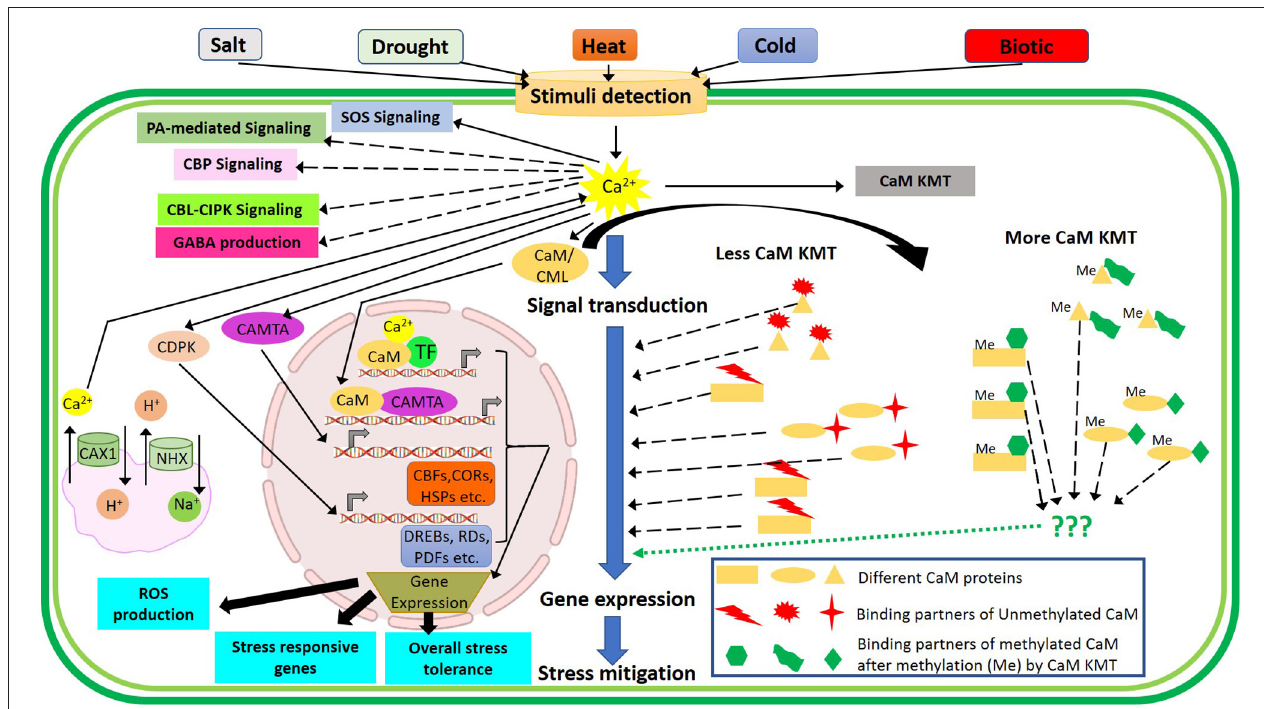
FIGURE 5 | Illustrative representation of crosstalk among Ca 2 + signaling components associated with multiple stimuli perceived by the plants. Spike in [Ca 2 + ] cyt triggers several pathways like SOS signaling, PA-mediated signaling, CBP signaling, CBL-CIPK signaling, GABA production, CAX1, and NHX regulation and activates CDPK, CAMTA, CaM, and CML for subsequent expression of stress-responsive genes in the nucleus depending on the types and magnitudes of stimuli. Calmodulin-lysine N-methyltransferase (CaM KMT) methylates CaM proteins in the cytosol while the methylated CaM (Me) and unmethylated CaM depicts differential interactions with CaM-binding partners (depicted in green and red shapes, respectively) and subsequently regulate the downstream signaling components to mitigate various stresses. CaM, calmodulin; CIPK, CBL-interacting protein kinases; CBLs, calcineurin B-like proteins; CDPKs, Ca 2 + -dependent protein kinases; CML, calmodulin-like